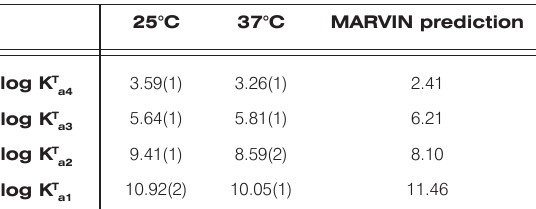
thermodynamic protonation constants of vardenafil at 25°C and 37°C. Standard deviations of protonation constants in the last valid digits are in